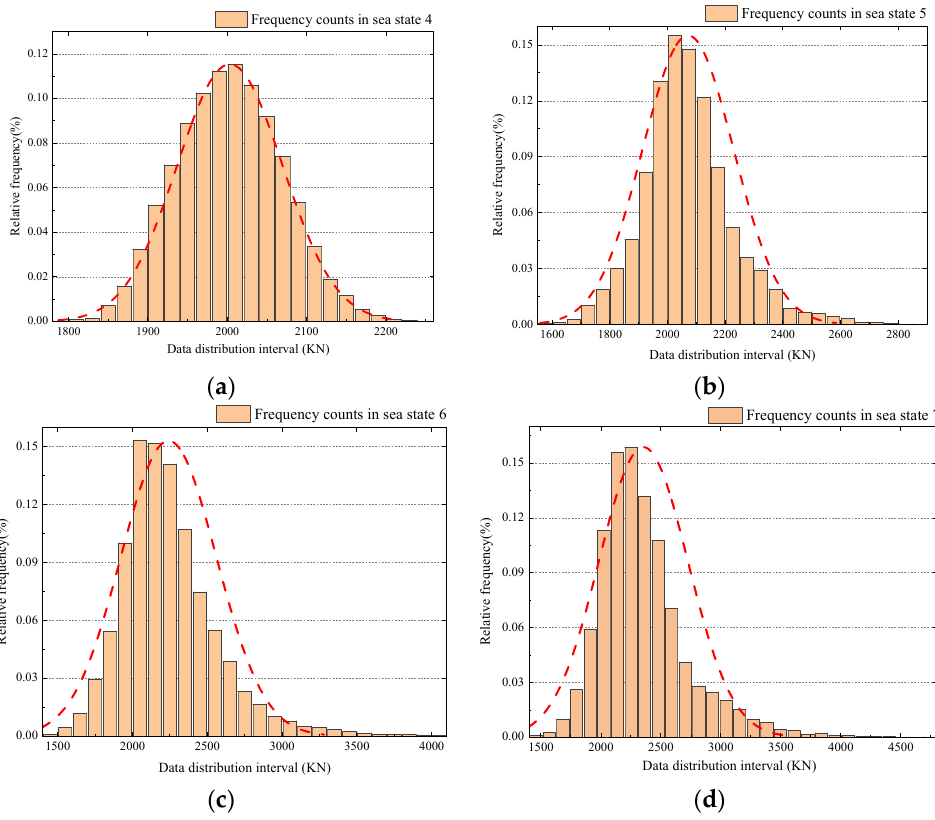
Figure 8. Frequency counts of line 1 in different sea states. ( a ) Frequency counts in sea state 4 (skew- ness = 0.108); ( b ) frequency counts in sea state 5 (skewness = 0.666); ( c ) frequency counts in sea state 6 (skewness = 1.148); and ( d ) frequency counts in sea state 7 (skewness = 1.274).